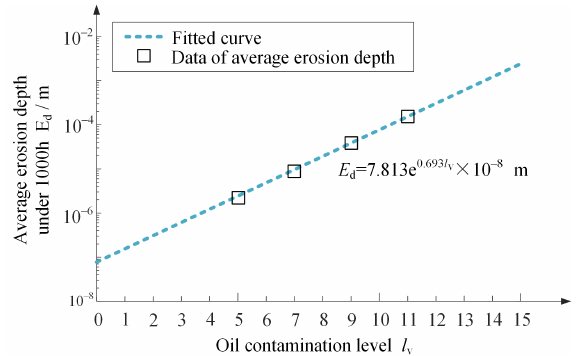
Figure 23. Average erosion depth with contamination level increasing.